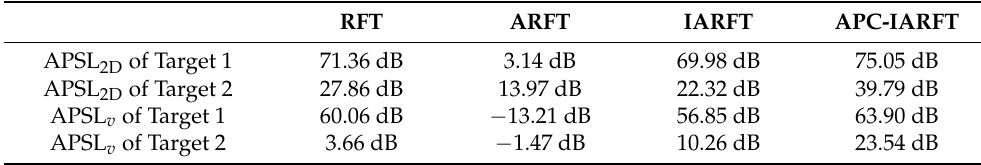
Table 2. APSL 2D and APSL v of the targets set in Scenario 1.